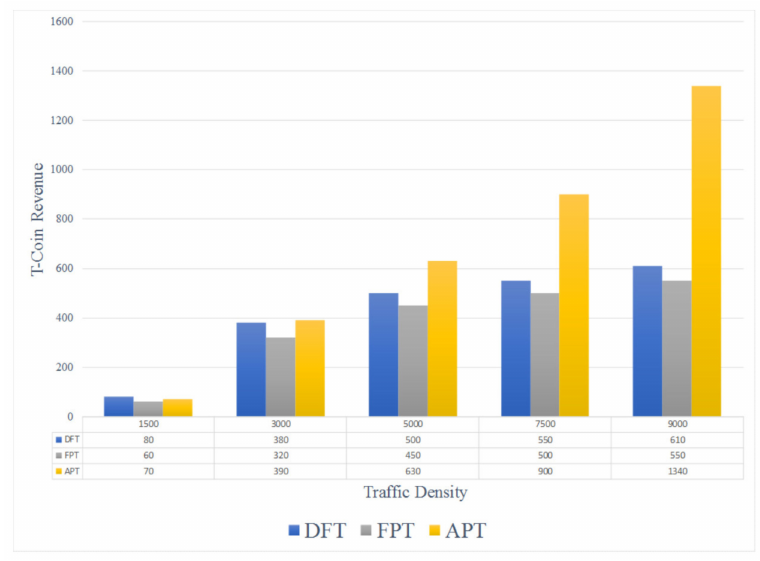
Figure 8. Tra ffi c density vs. T-coin